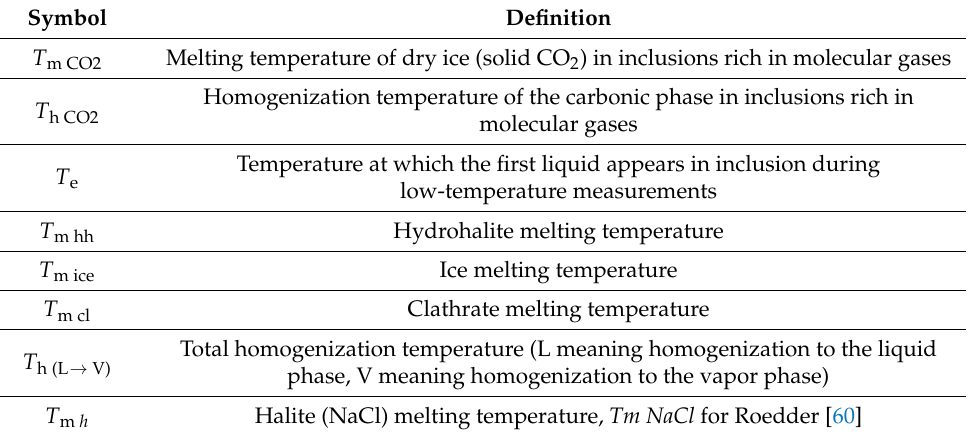
Table 1. Abbreviations for microthermometric data [60].